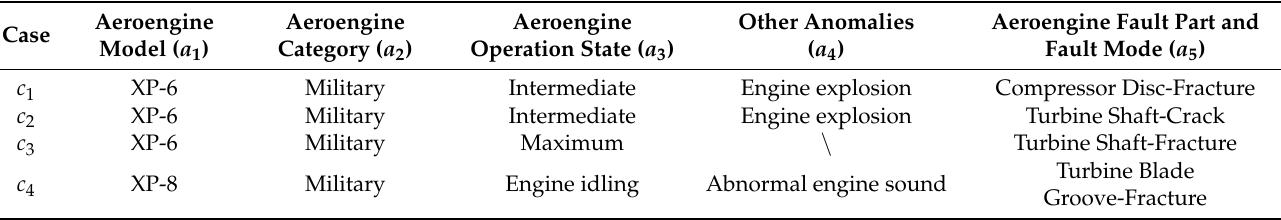
Table 2. Four cases in the case base.